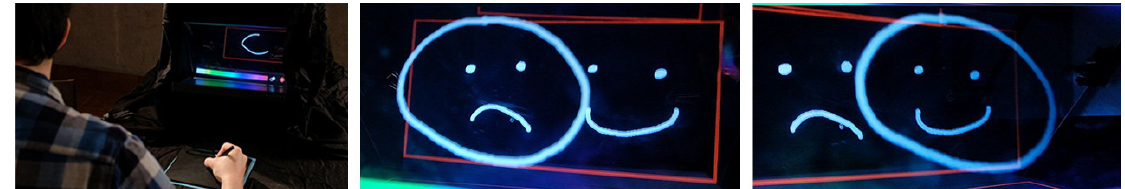
Figure 12. User painting in SlicePainter at different layers; depending on the point of view, the layers align differently and provide different